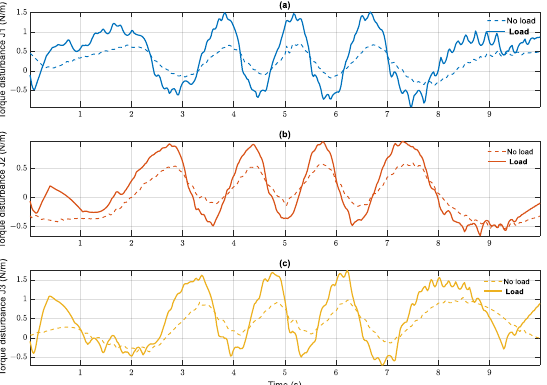
Table 12. The property comparison among the controllers and